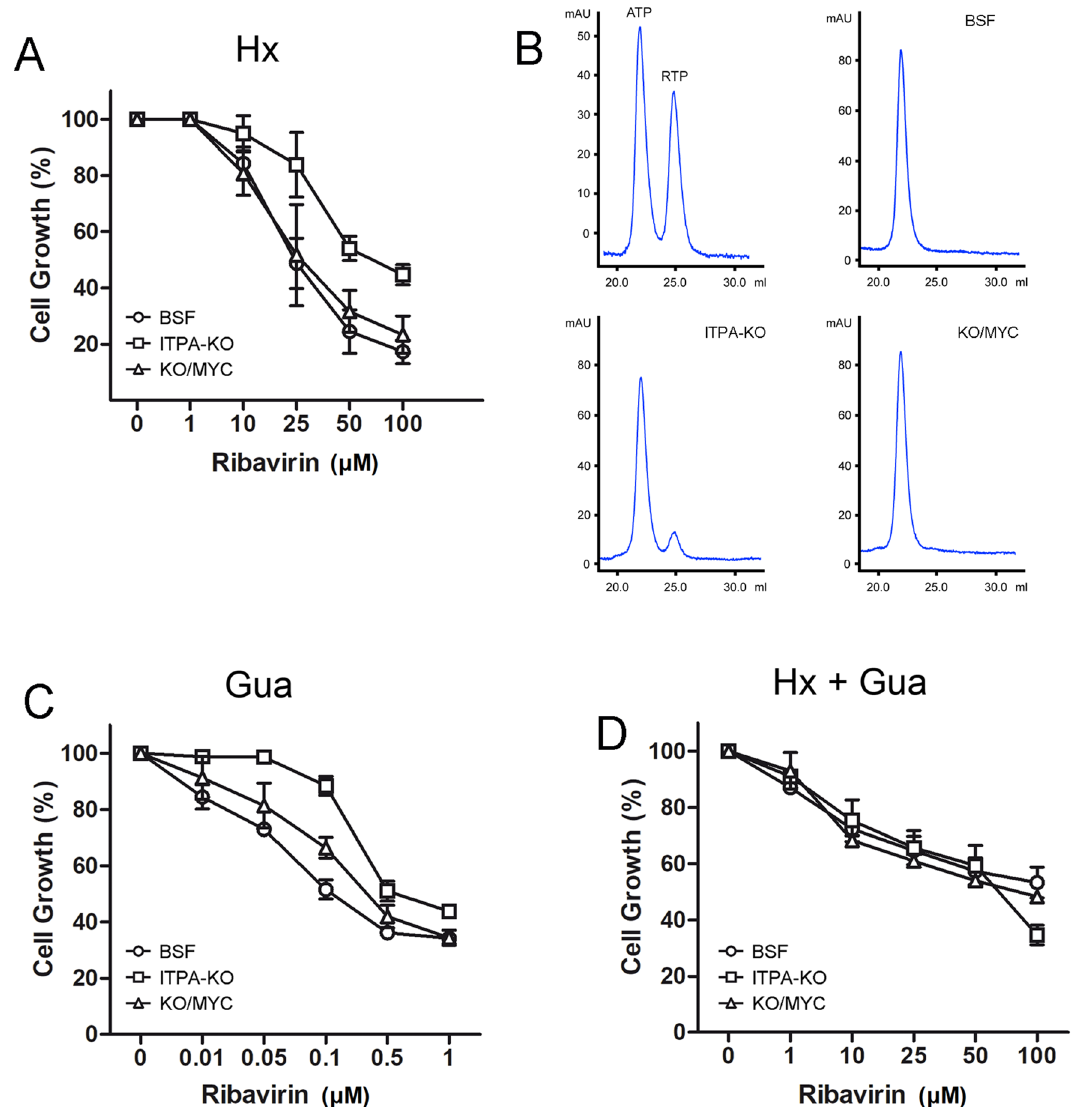
ribavirin (RBV) for 24 h at 37 °C in HMI-9 medium containing hypoxanthine (1 mM) as the sole purine source. ( B ) Intracellular detection of RTP by anion exchange chromatography. Top left panel represents the elution standards for ATP and RTP ( C ) Ribavirin sensitivity assay was performed in modified HMI-9 medium containing guanine (100 μM) as the sole purine source. ( D ) Ribavirin sensitivity assay was performed in modified HMI-9 medium containing guanine (100 μM) and hypoxanthine (100 μM). Values are the mean (± SD) of at least three independent experiments. Cell lines are represented with the following symbols: BSF (circle), ITPA-KO (square), KO/myc-ITPA in the presence of 1 μg mL −1 of doxycycline